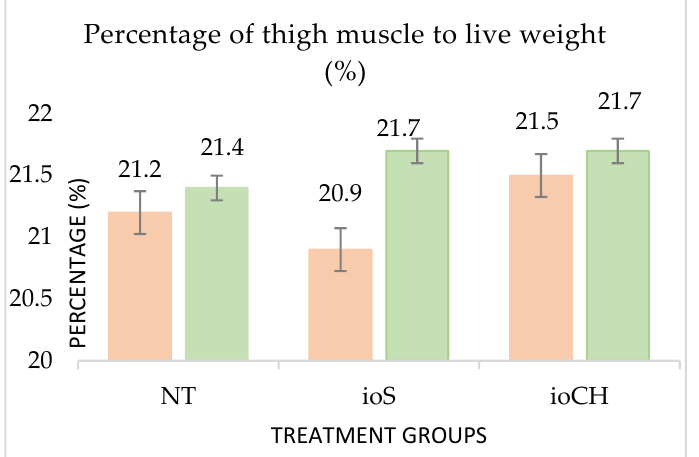
Figure 4. Effects of treatment and sex on thigh ( p = 0.6 and 0.24) and breast ( p = 0.01 and 0.4) muscle percentage compared to live weight. Pink columns represent pullets; green columns represent roosters. The error bars represent standard deviations.